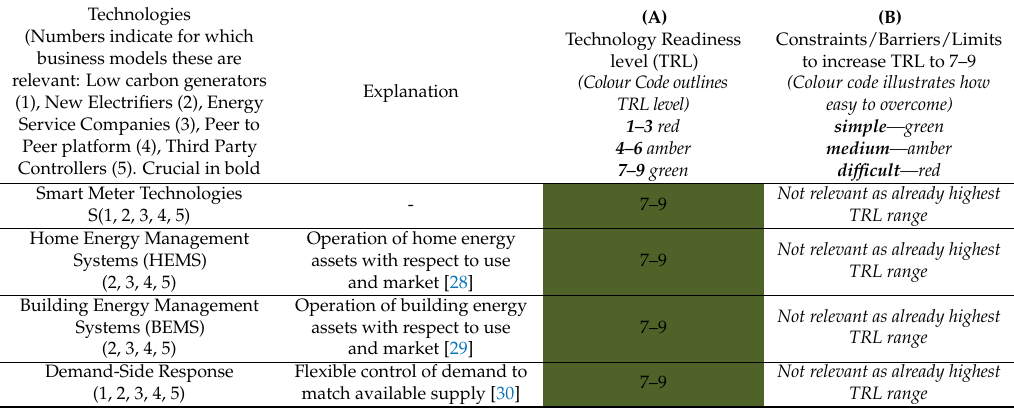
Table 5. TRLs of Data and Energy System Integration